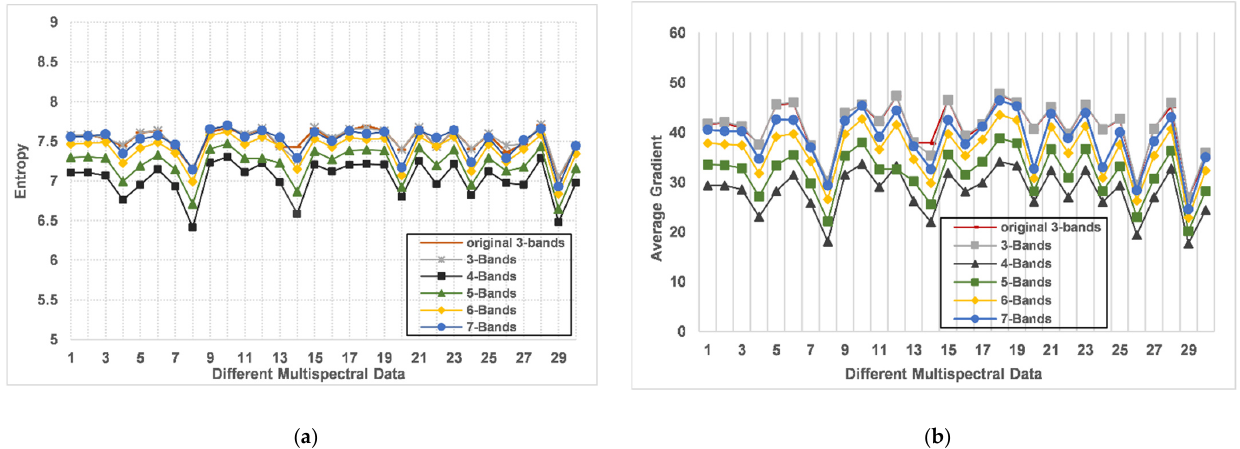
Figure 11. The quantitative results of different input bands combinations used in 30 multispectral data: ( a ) entropy; ( b ) average gradient. data: ( a ) entropy; ( b ) average gradient.